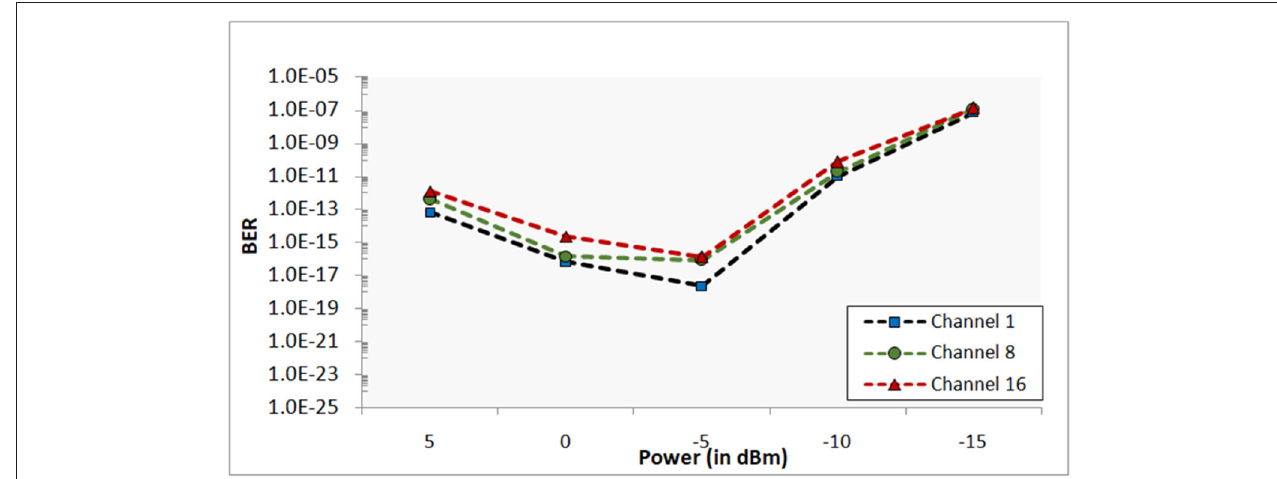
FIGURE 4 | Variation of BER with power at channel spacing of 50 GHz.